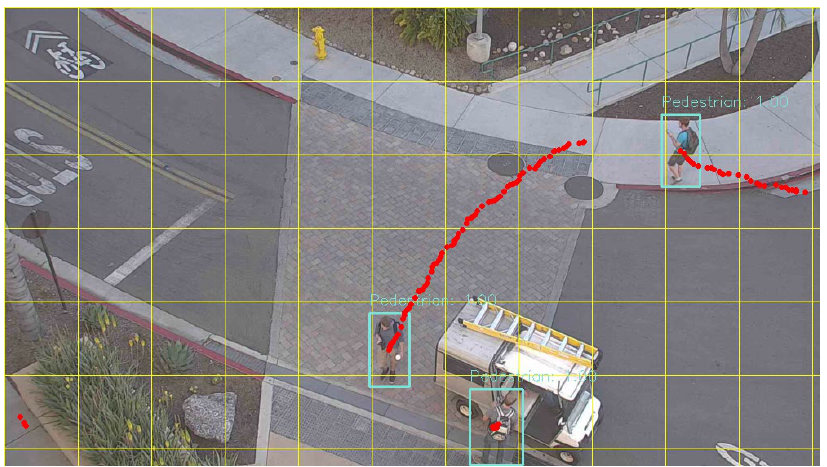
Figure 29. Object detection model drawing contrails of pedestrians only.